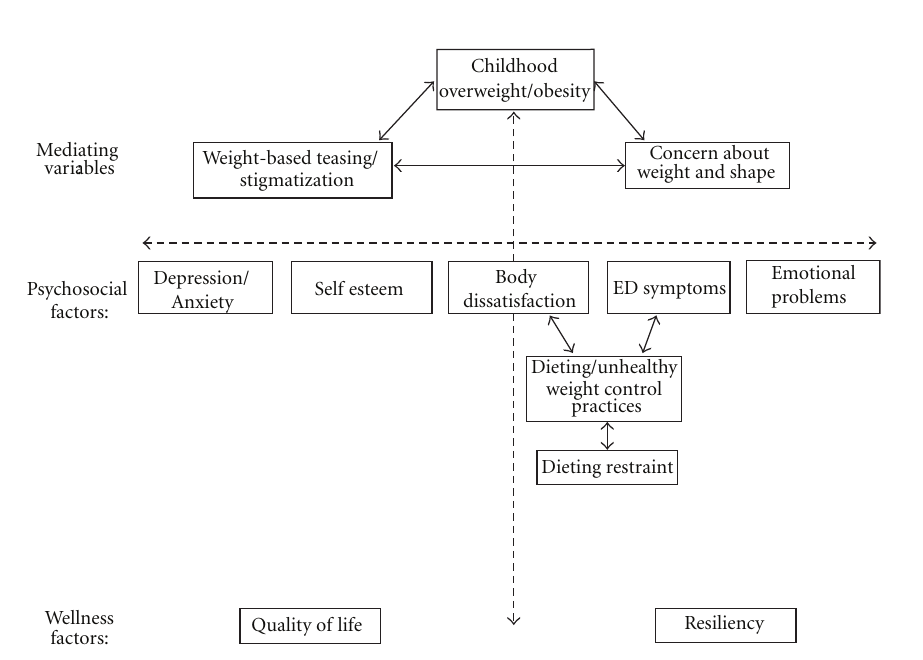
Figure 1: Proposed